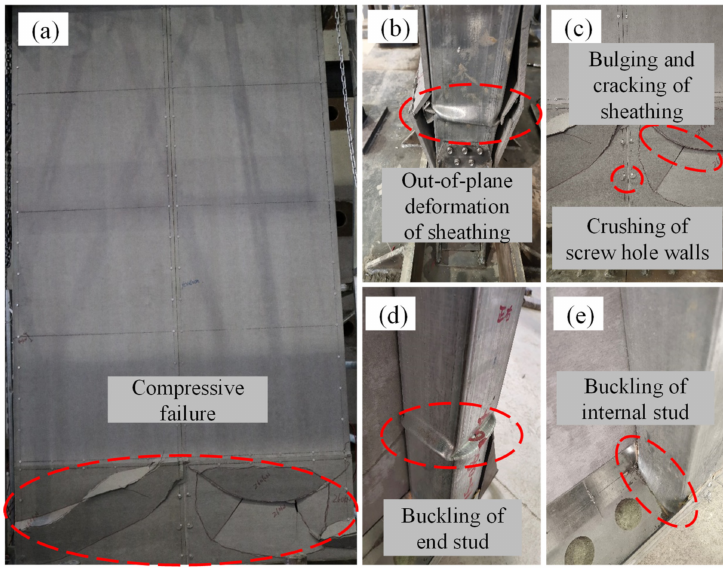
Figure 6. Failure of specimen